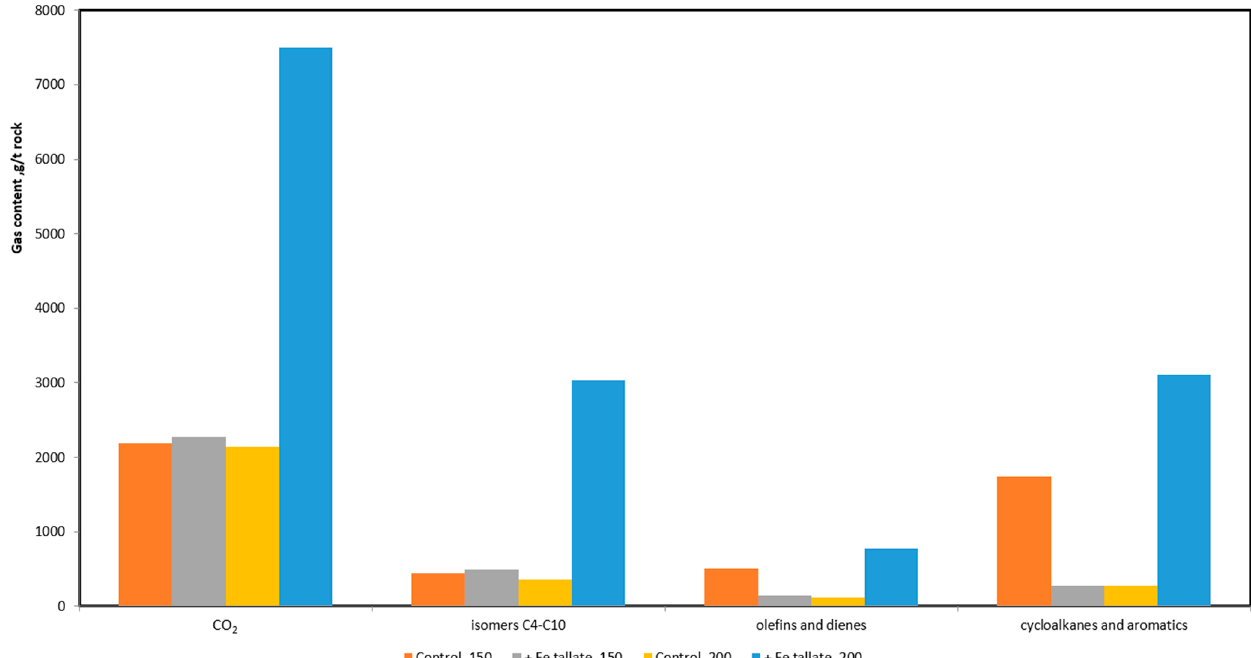
Figure 3. The content and composition of gases (CO 2 , C4-C10 isomers, olefins and dienes, cycloalkanes and aromatic HCs) depending on TST temperature and the presence of iron tallate.